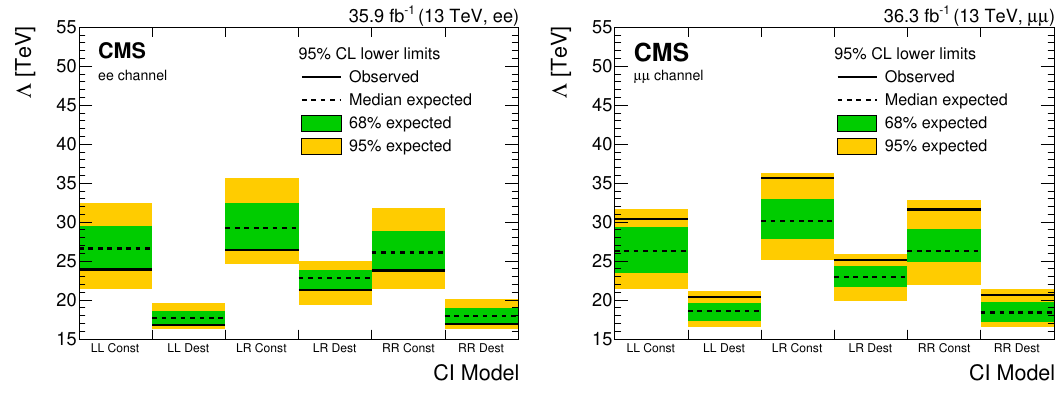
Figure 2 . Dilepton exclusion limits at 95% CL on the CI scale ((cid:3)) for the six CI models considered for the electron (left) and muon (right) channels. The limits are obtained for m ‘‘ > 400 (2200) GeV in the case of constructive (destructive) interference.